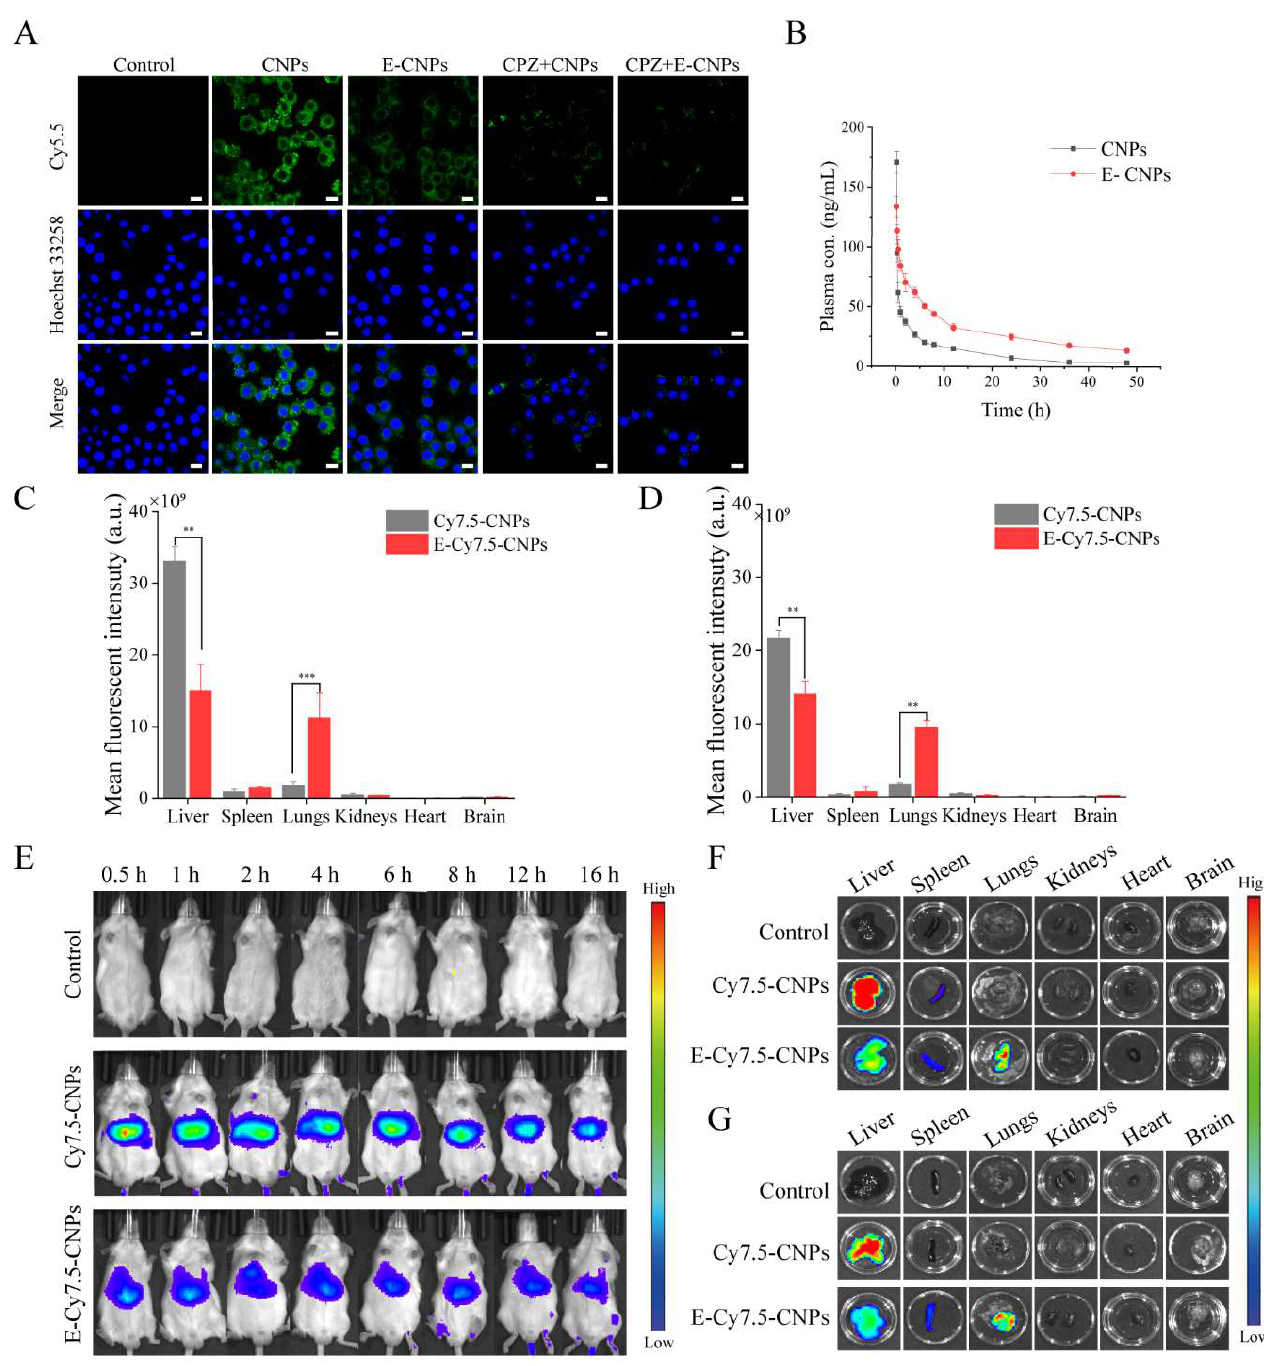
Figure 5. Long circulation features and biodistribution evaluation of E-CNPs in vivo. ( A ) CLSM visualization images of RAW264.7 macrophages incubated with Cy5.5-CNPs or E-Cy5.5-CNPs for 2 h (scale bar = 10 μm). ( B ) Mean plasma Cy5.5 concentration in blood following single-dose IV injection of Cy5.5-CNPs or E-Cy5.5-CNPs in rats ( n = 3). ( C – G ) Distribution of fluorescent signals in mice. Mice were injected intravenously with Cy7.5-CNPs or E-Cy7.5-CNPs and observed at preset time points using a small animal imaging system. The mice were euthanized 6 and 16 h after administration, and their organs were obtained, imaged, and analyzed. Levels of Cy7.5 signal accumulated in the lungs and liver at 6 h ( C ) and 16 h ( D ) after injected. ( E ) Biodistribution analyses of Cy7.5-labeled formulations in vivo. Biodistribution of Cy7.5 fluorescence signal images in isolated organs at 6 h ( F ) and 16 h ( G ). ( n = 3, mean ± SD, ** p < 0.01, and *** p < 0.001).